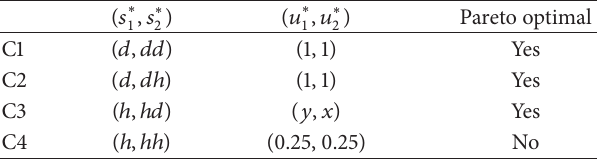
Table 4: SPNE in the conflict game with perfect